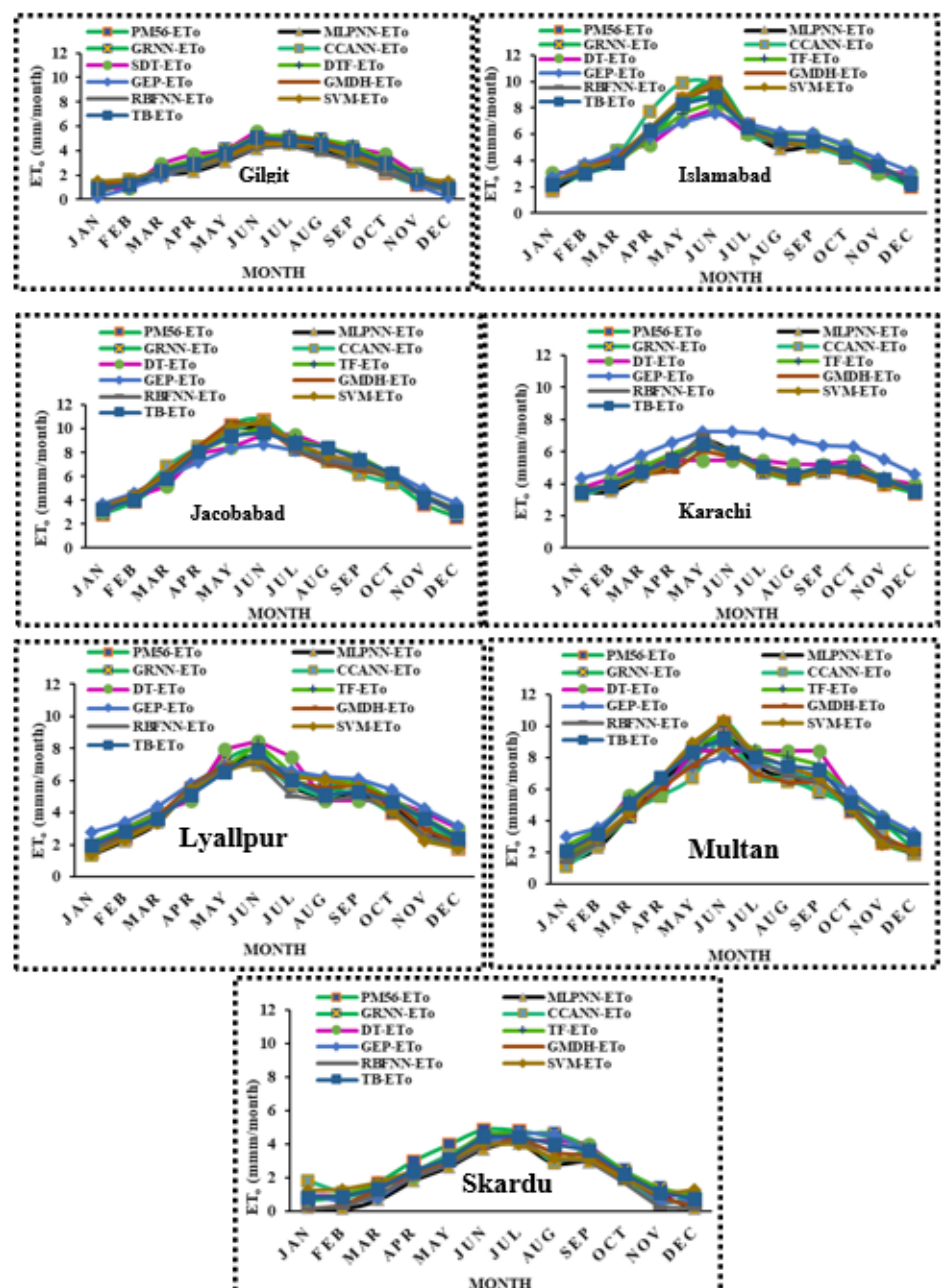
Figure 9. ET o comparison of the applied ML models with the FAO PM56 method.